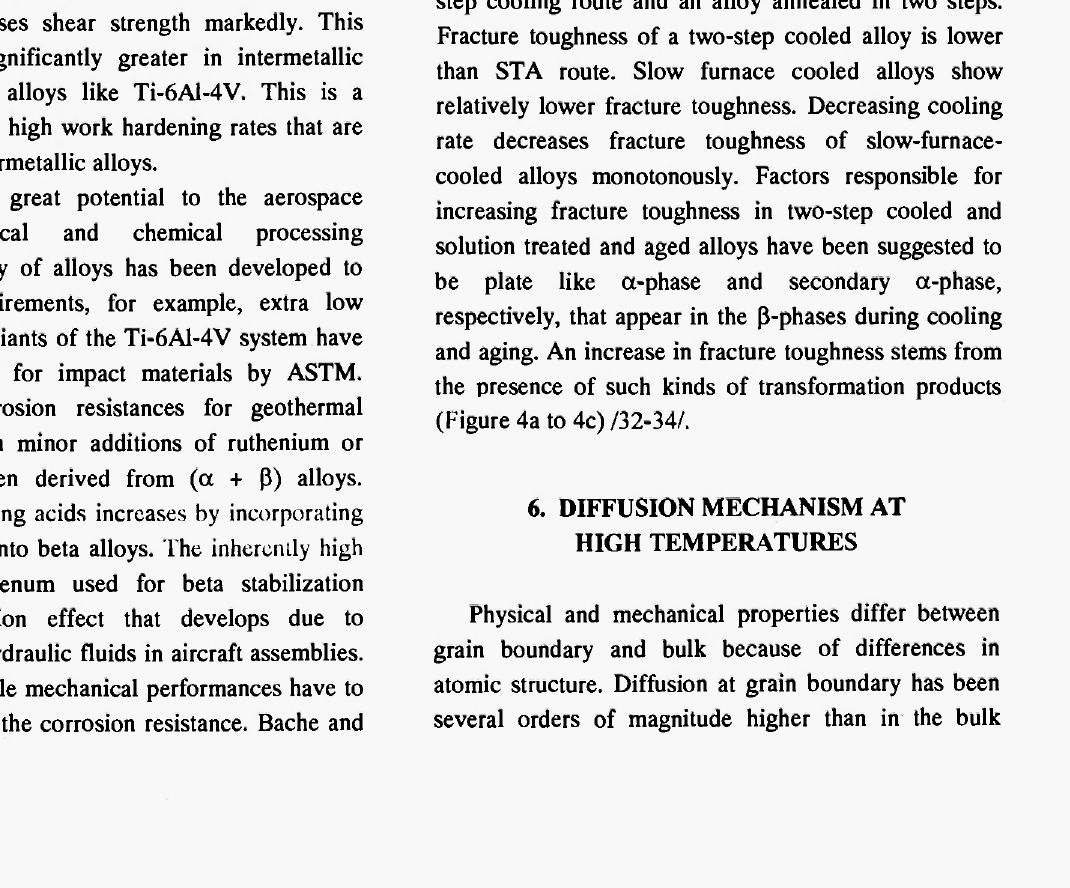
Fig. 3: Effect of prior B2-grain size on the room temperature tensile strength